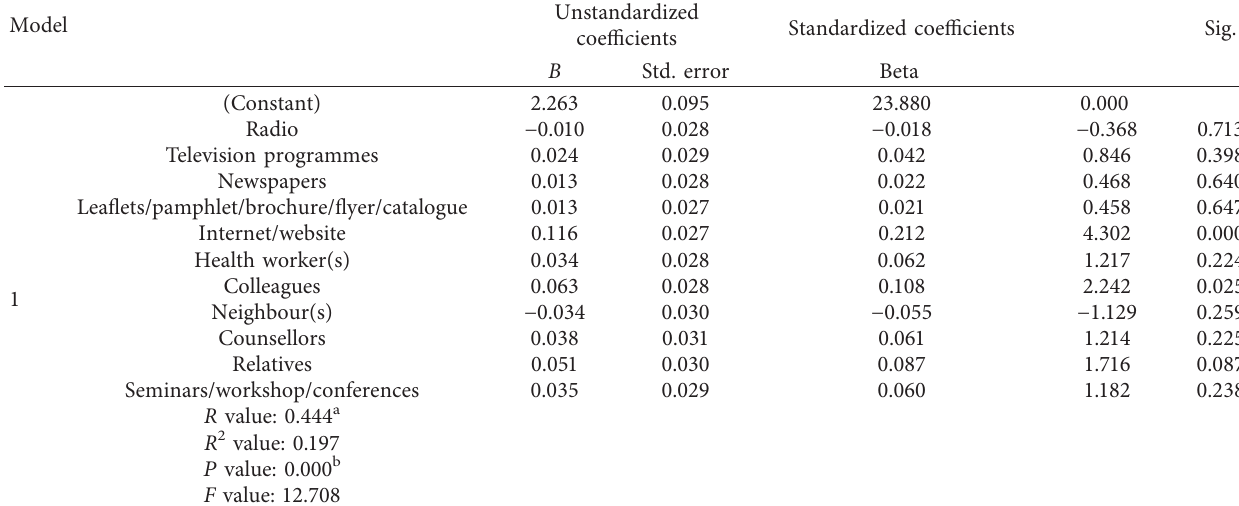
Table 2: Coefficients of health communication channels and knowledge on hepatitis B